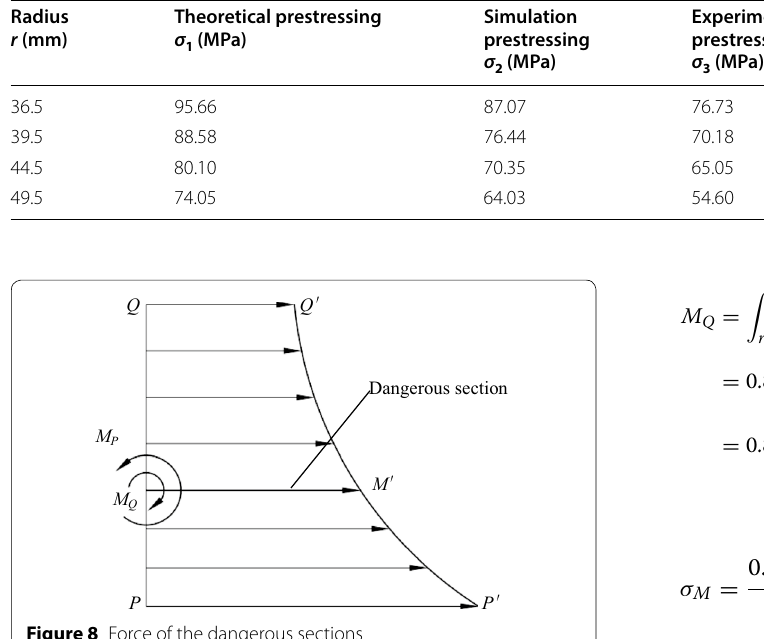
in experiment 8 Ia 8